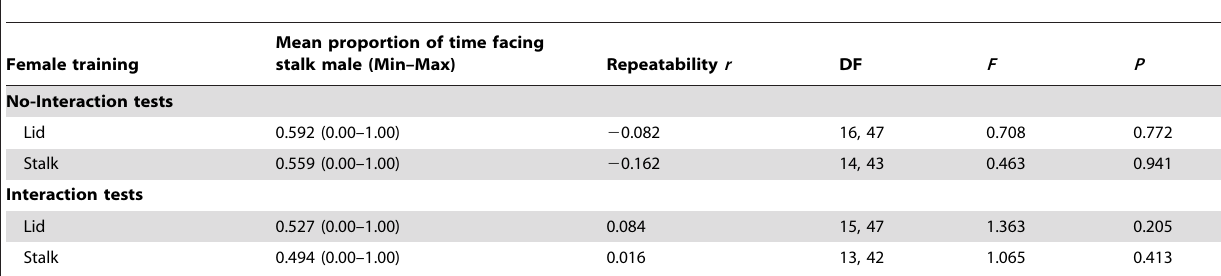
Table 3. Repeatabilities ( r ) of female preferences for stalk male’s compartment.